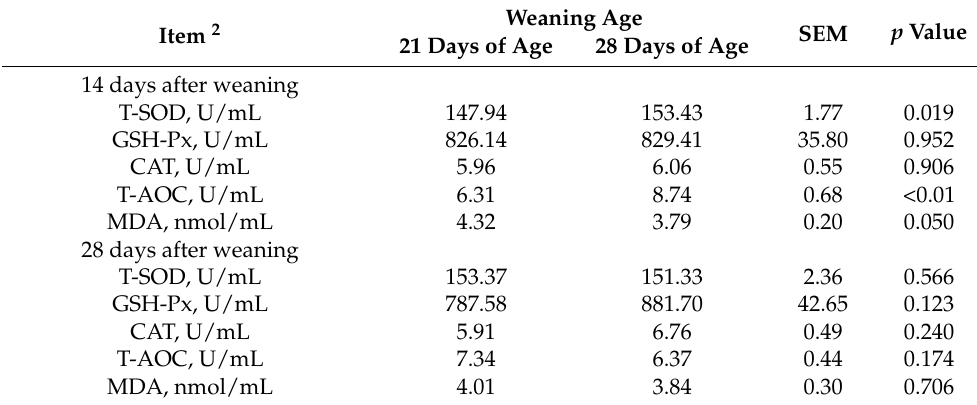
Table 12. Effect of weaning age on serum antioxidant indexes of weaned pigs 1 . Item